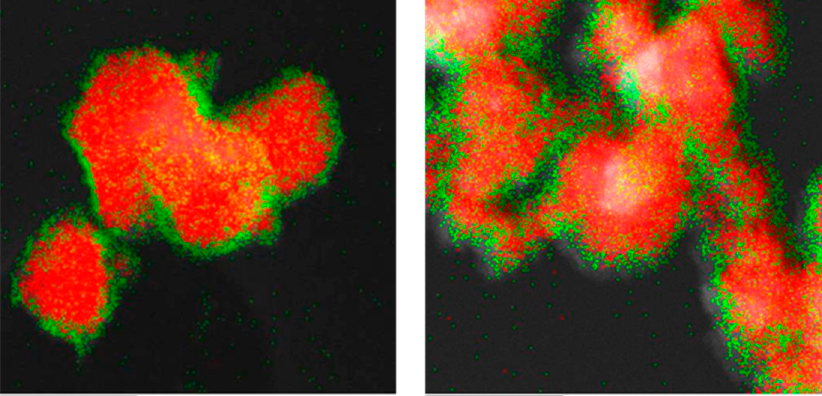
Figure 7. Overlapping of the signals coming from silicon atoms (in SiC, red color as in Figure 5b–B) and that coming from iron atoms (in Fe 3 O 4 , green color as in Figure 5b–C) in Fe 3 O 4 @SiC core–shell NPs (lab synthesis). The thickness of the magnetite shell is revealed.